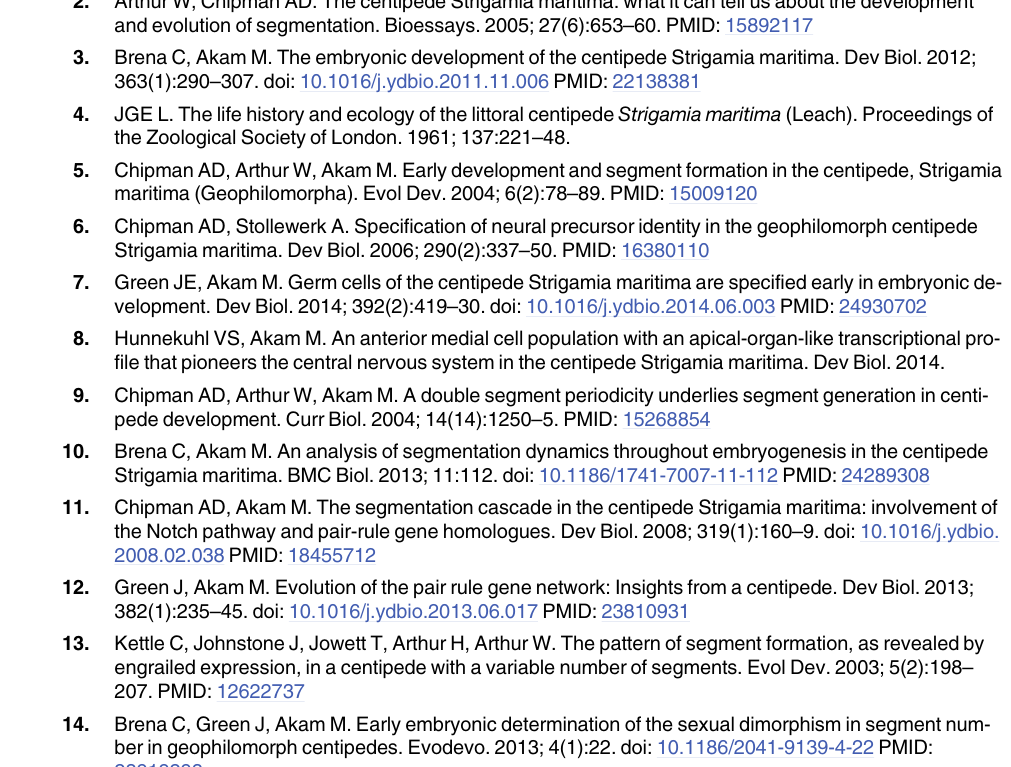
S2 Table. GenBank accession numbers for taxa used in this